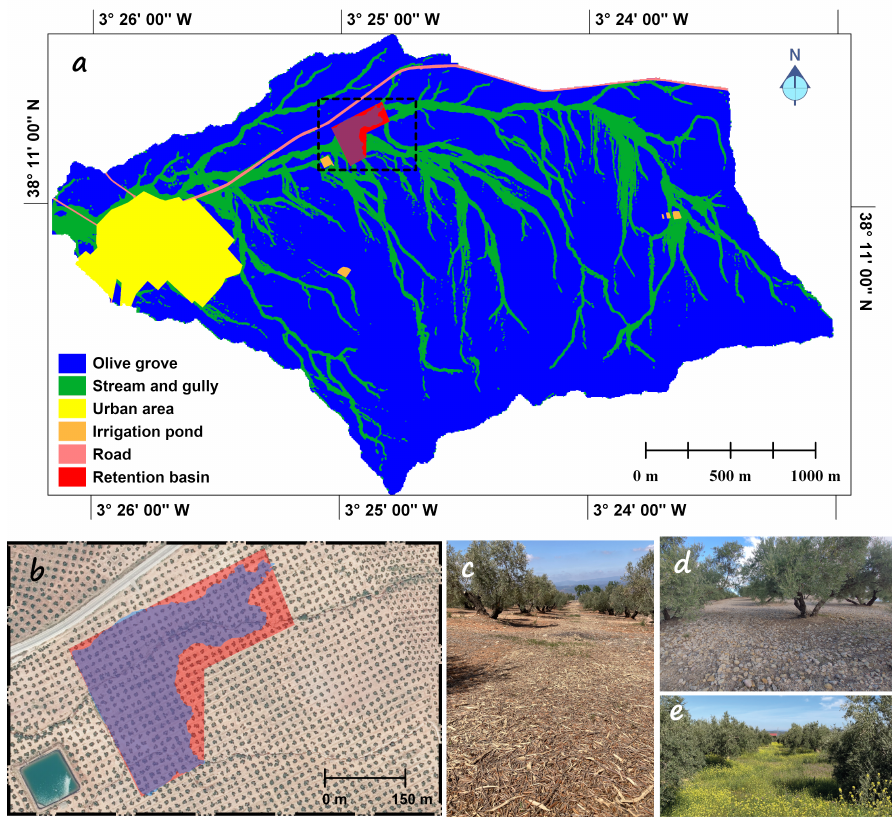
Figure 4. ( a ) Regions defined in Section 2.2.3 to assign the Manning roughness. ( b ) Orthophoto in the dashed rectangular area of panel a showing sandy clay loam on the surface outside the olive tree canopy projection and inside streams because of the herbicide uses. The blue and red polygons are possible retention basins based on an artificial wetland or a large irrigation pond. ( c – e ) Possible NbS using ground branches, gravels and natural full-cover